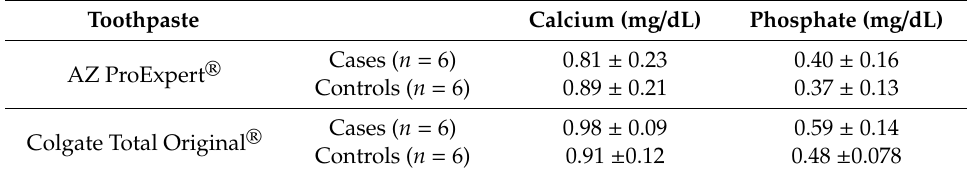
Table 2. Enamel samples in hydrochloric acid